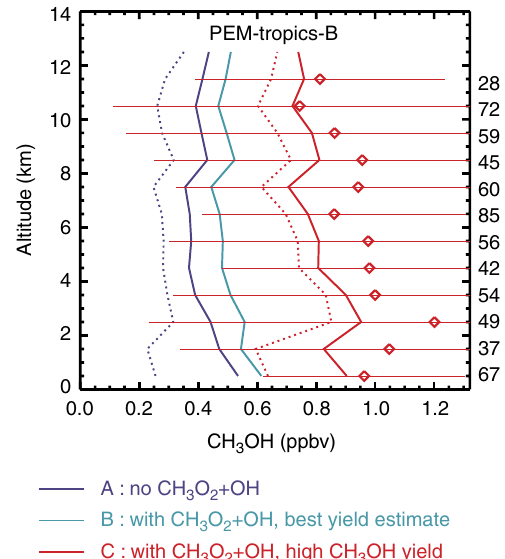
Figure 5 | Measured and modelled methanol over the remote Tropical Pacific. Measurements from the Pacific Exploratory Mission in the tropical Pacific (PEM-Tropics-B) 6 . Solid (dotted) lines denote simulations including (excluding) the oceanic source of methanol. The number of measurements per altitude bin is indicated on the right. The error bars represent the s.d.’s of the measurements. The nominal precision of the measurements was 25% (ref.